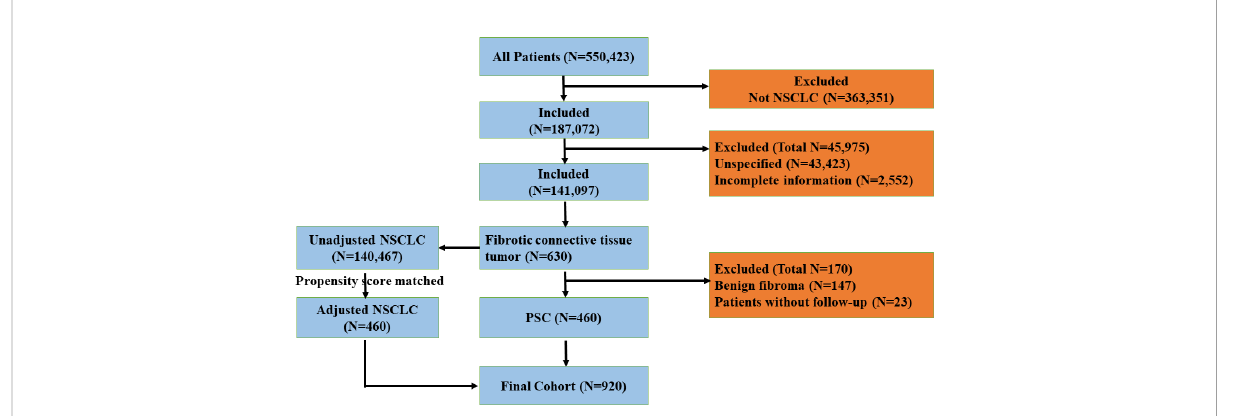
FIGURE 1 The fl owchart of exclusion criteria and study design. PSC, pulmonary sarcomatoid carcinoma; NSCLC, non-small-cell lung